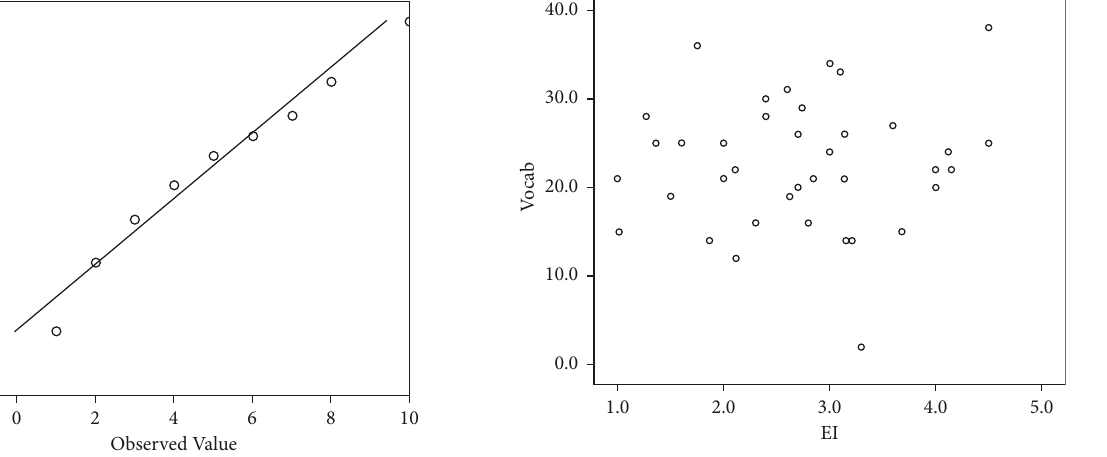
Figure 4: The relationship between vocabulary knowledge and emotional intelligence